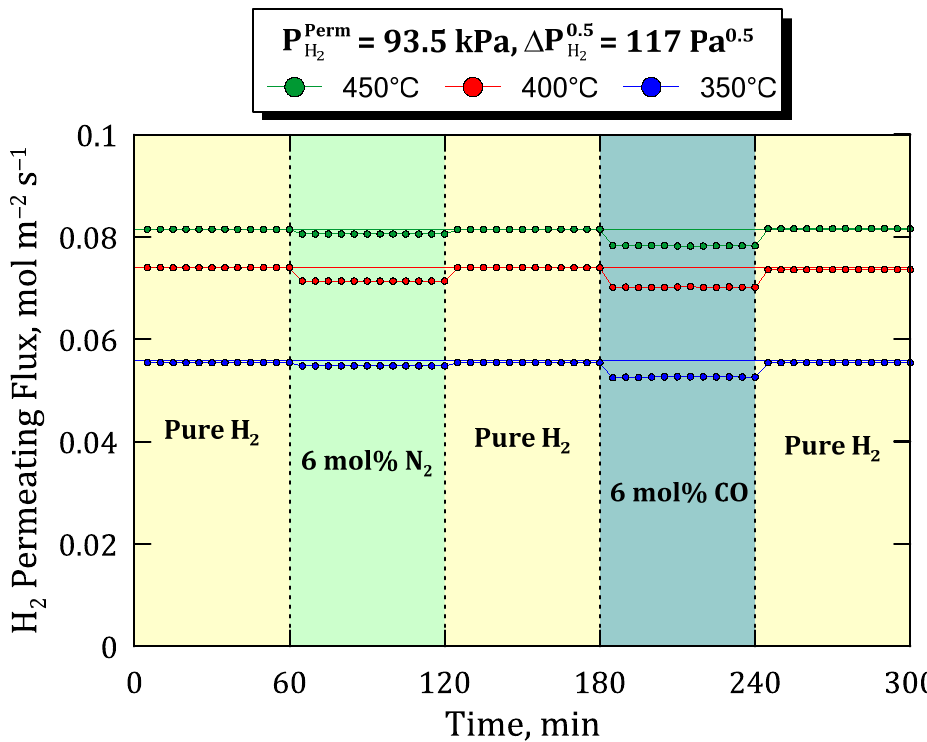
Figure 12. Time profile of hydrogen permeating flux at different temperatures with feed mixtures containing 6 mol% of N 2 or CO ( P Perm